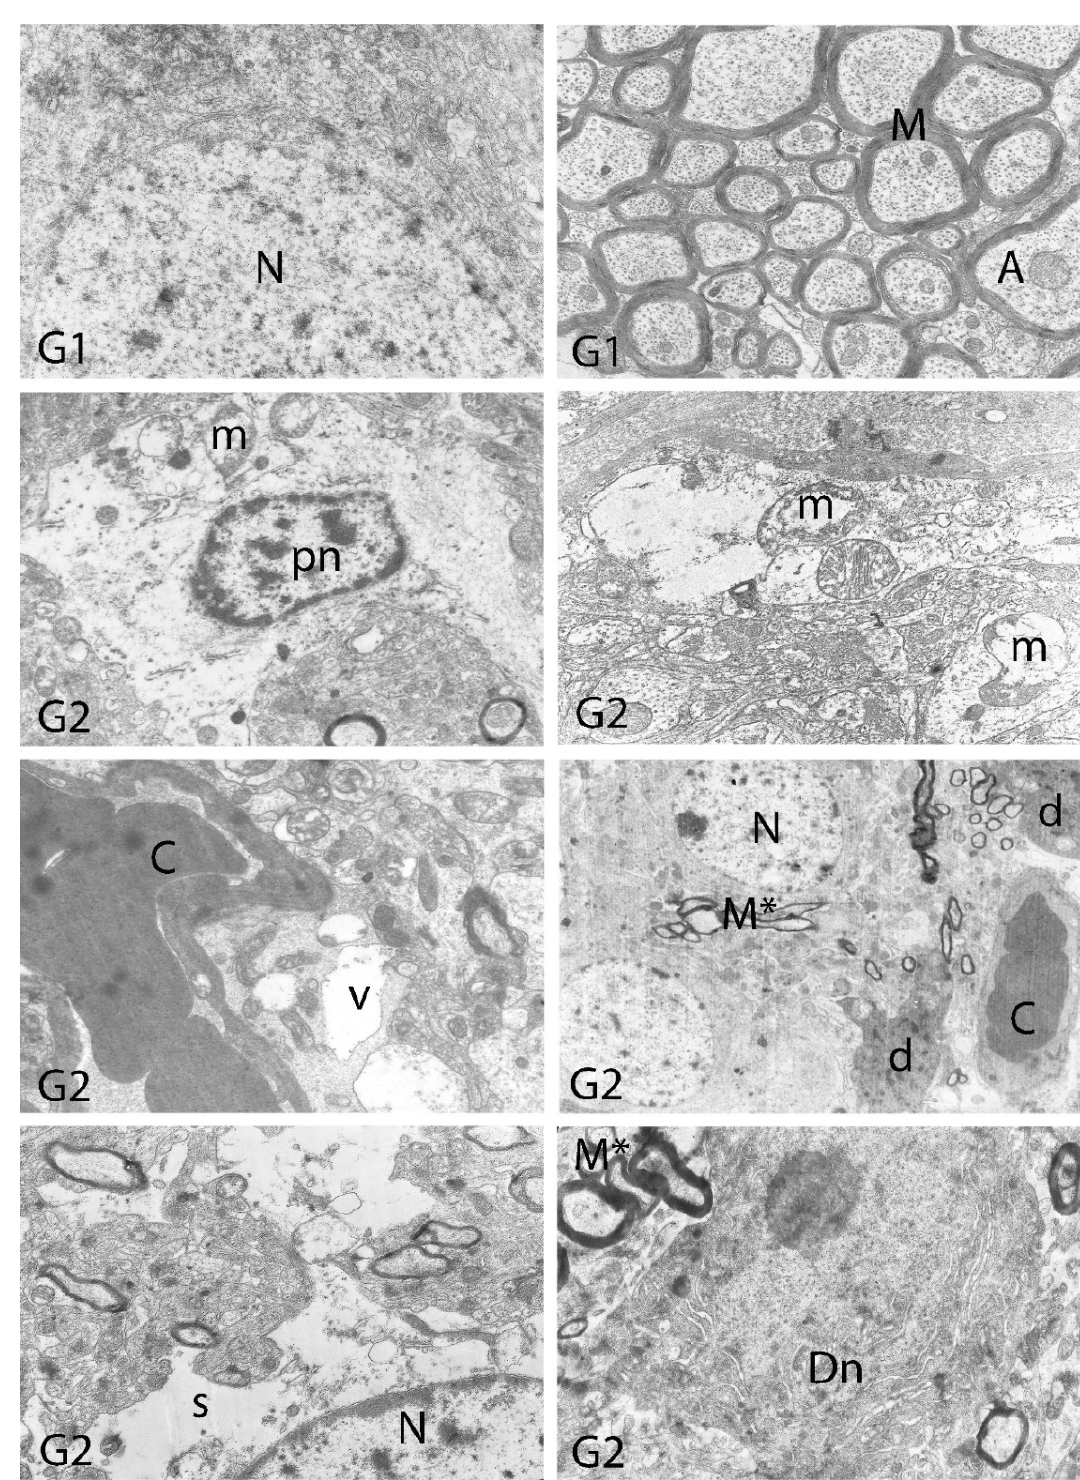
Figure 14. Electron micrographs of rat hippocampi from Groups 1 (G1) and 2 (G2). N, nucleus; M, intact myelin; A, axon; pn, pyknotic nucleus; m, damaged mitochondria; C, capillary; v, vacuolar degeneration; M*, distorted myelin figures; d, neuronal debris; s, swollen cytoplasm; Dn, electron dense degenerated neuron. Group definitions are as in Figure 9.